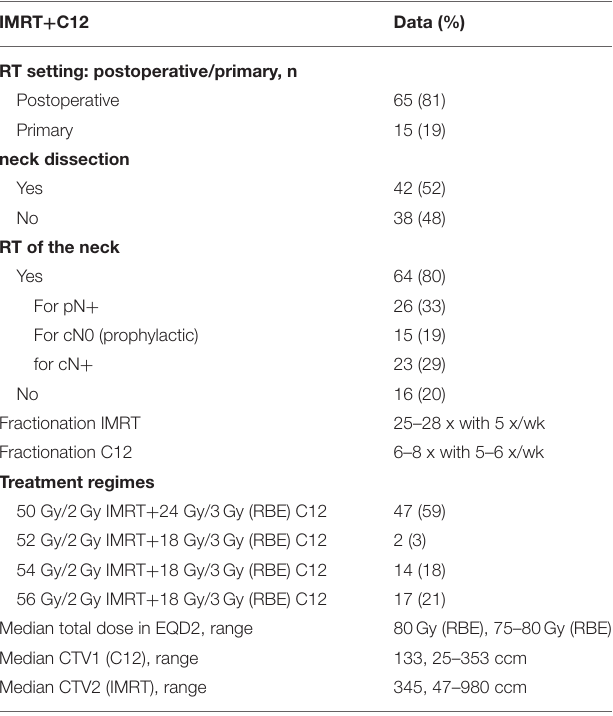
performance score 2 (vs. ECOG 0; Supplementary Figure 2C ; p = 0.0329, HR = 2.825, 95%-CI = 1.088–7.335) and N + (vs. N0; Supplementary Figure 2D ; p = 0.019, HR = 3.100, 95%-CI = 1.205–7.976) could be identified as independent negative prognostic factors. Additionally, female gender (vs. male; Supplementary Figure 2B ; p = 0.0479, HR = 0.4079, 95%-CI = 0.146–1.143) and operable tumors (vs. inoperable; Supplementary Figure 2A ; p = 0.0171, HR = 0.341, 95%-CI = 0.141–0.826) were associated with significantly increased and N + (vs. N0; p = 0.009; HR = 2.980, 95%-CI = 1.318–6.741)